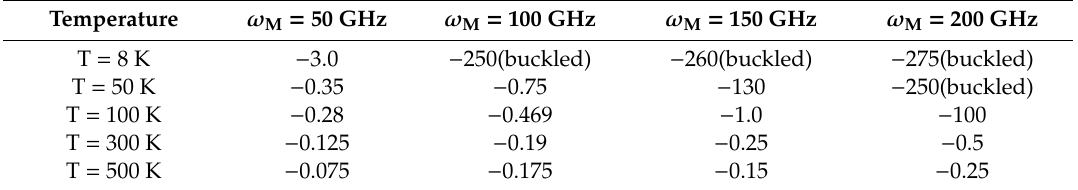
Table 4. M rcr on the rotor in the armchair model with Gap = 1.5 nm. Moment unit: